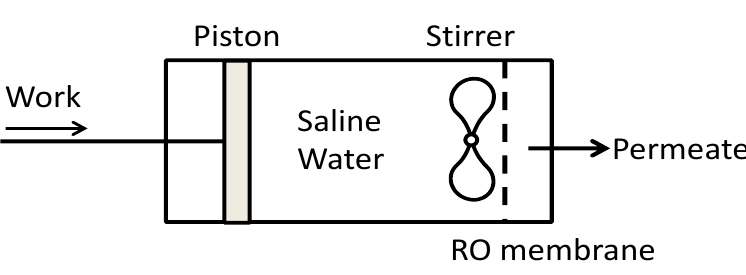
Figure 8. The essence of the batch mode RO process.